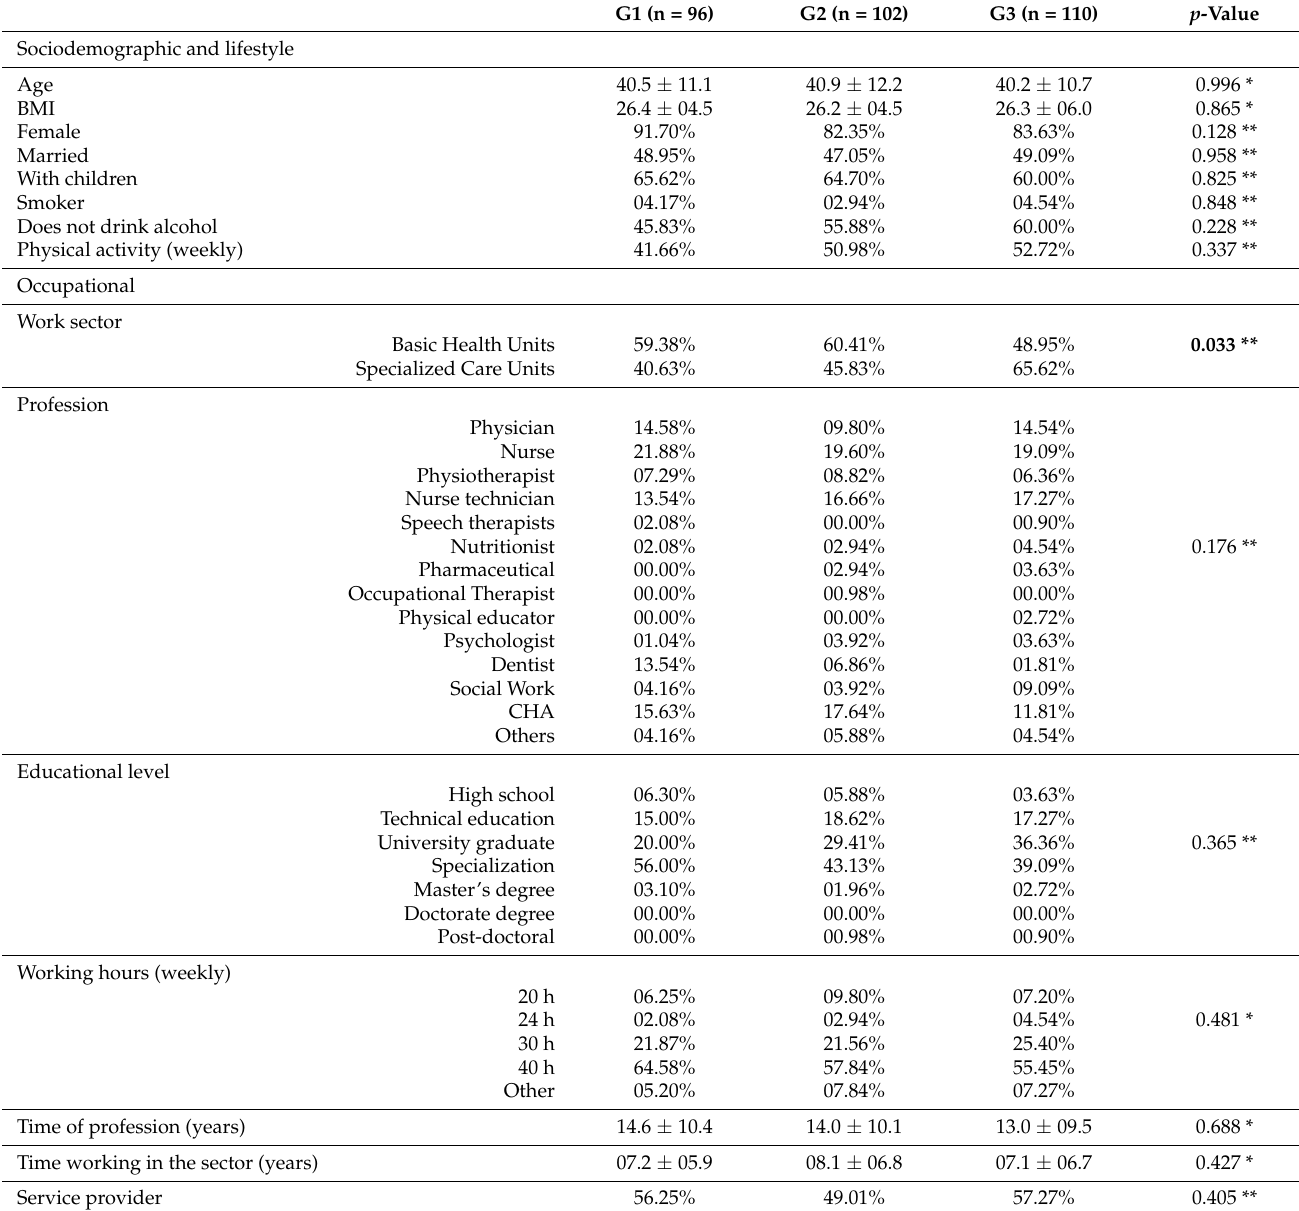
Table 1. Sample characteristics (mean ± standard deviation;